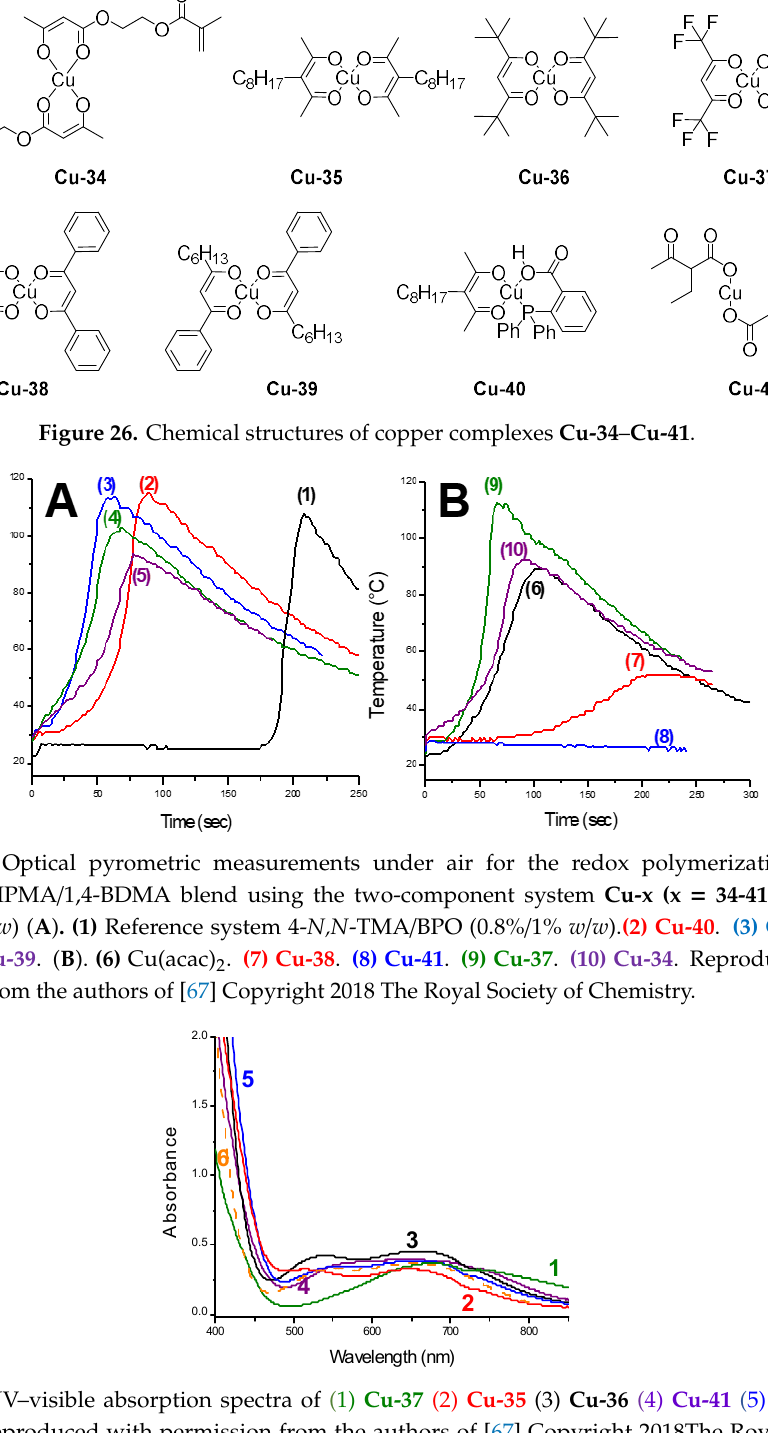
Figure 29. The dual source of radicals upon photoactivation of the redox process. To evidence the advantages of light activation on the polymerization, tempol, which is a radical trapping agent, was added into the resins. As shown in Figure 30, benefits of the light activation for Cu-37 (at 785 nm) or for Cu-35 (at 405 nm or at 785 nm) could be clearly demonstrated, inducing a clear reduction of the reaction time while improving the final monomer conversions. Four-hundred-and-five nanometers and 785 nm were selected as the irradiation wavelengths in this study due to the panchromatic absorptions of Cu-35 – Cu-38 and Cu-41 , so that photoactivation of the polymerization process is possible from the near-UV to the near-infrared range. Precisely, 405 nm was chosen as the first irradiation wavelength as this wavelength is currently under use in dentistry, notably for tooth filling and restoration. However, dental cements used to glue tooth structures such as crowns or bridges requires redox processes to be used as the light irradiation is not possible to chemically bond the different elements. To speed up the polymerization reaction, the redox process can be accelerated “on demand” by light irradiation, supporting the interest for (photo) redox polymerization processes. As far as the irradiation at 785 nm was concerned, a good light penetration can be obtained at long wavelength, as shown in the diagram presented in the Figure 1. The exceptional light penetration achievable at 785 nm can also be of interest for dental applications (filling of premolars and molars), but also for the polymerization of resins containing fillers [126– 128]. By monitoring the C = C double bond conversion by Fourier transform infrared spectroscopy (FTIR), a two-fold reduction of the reaction time was obtained with Cu-37 (37 s vs. 55 s without NIR light activation) with the two-component Cu-37 /2-dppba/Iod (0.7%/1.5%/1.5% w / w / w ) system. The most representative example of the light activation was obtained with Cu-35 . Indeed, if no polymerization was detected with the two-component Cu-37 /2-dppba/Iod (0.7%/1.5%/1.5% w / w / w )